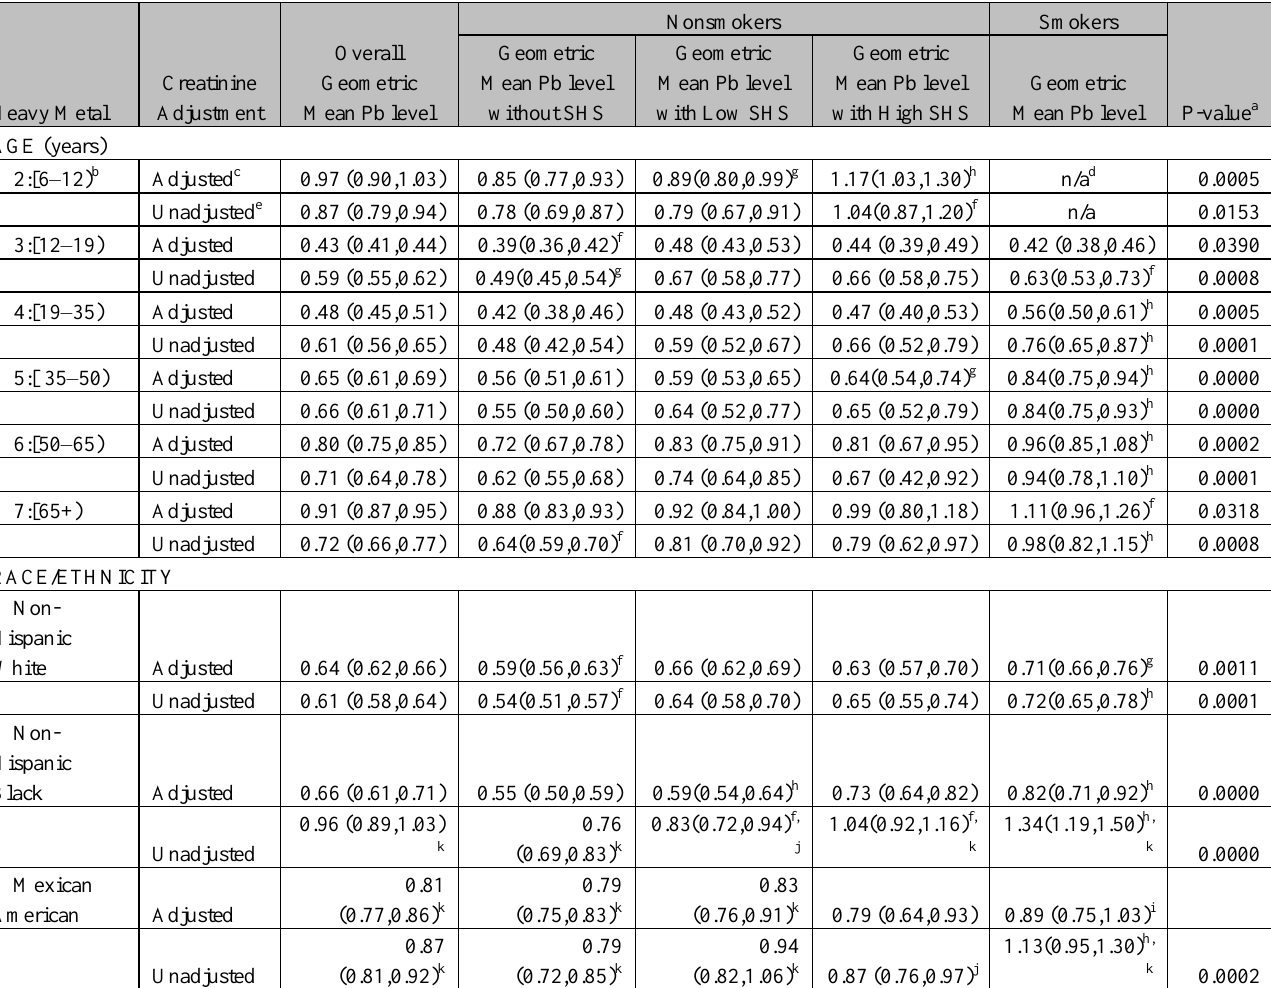
Table 4. Geometric Means and P-values Overall and by Level of Smoke Exposure